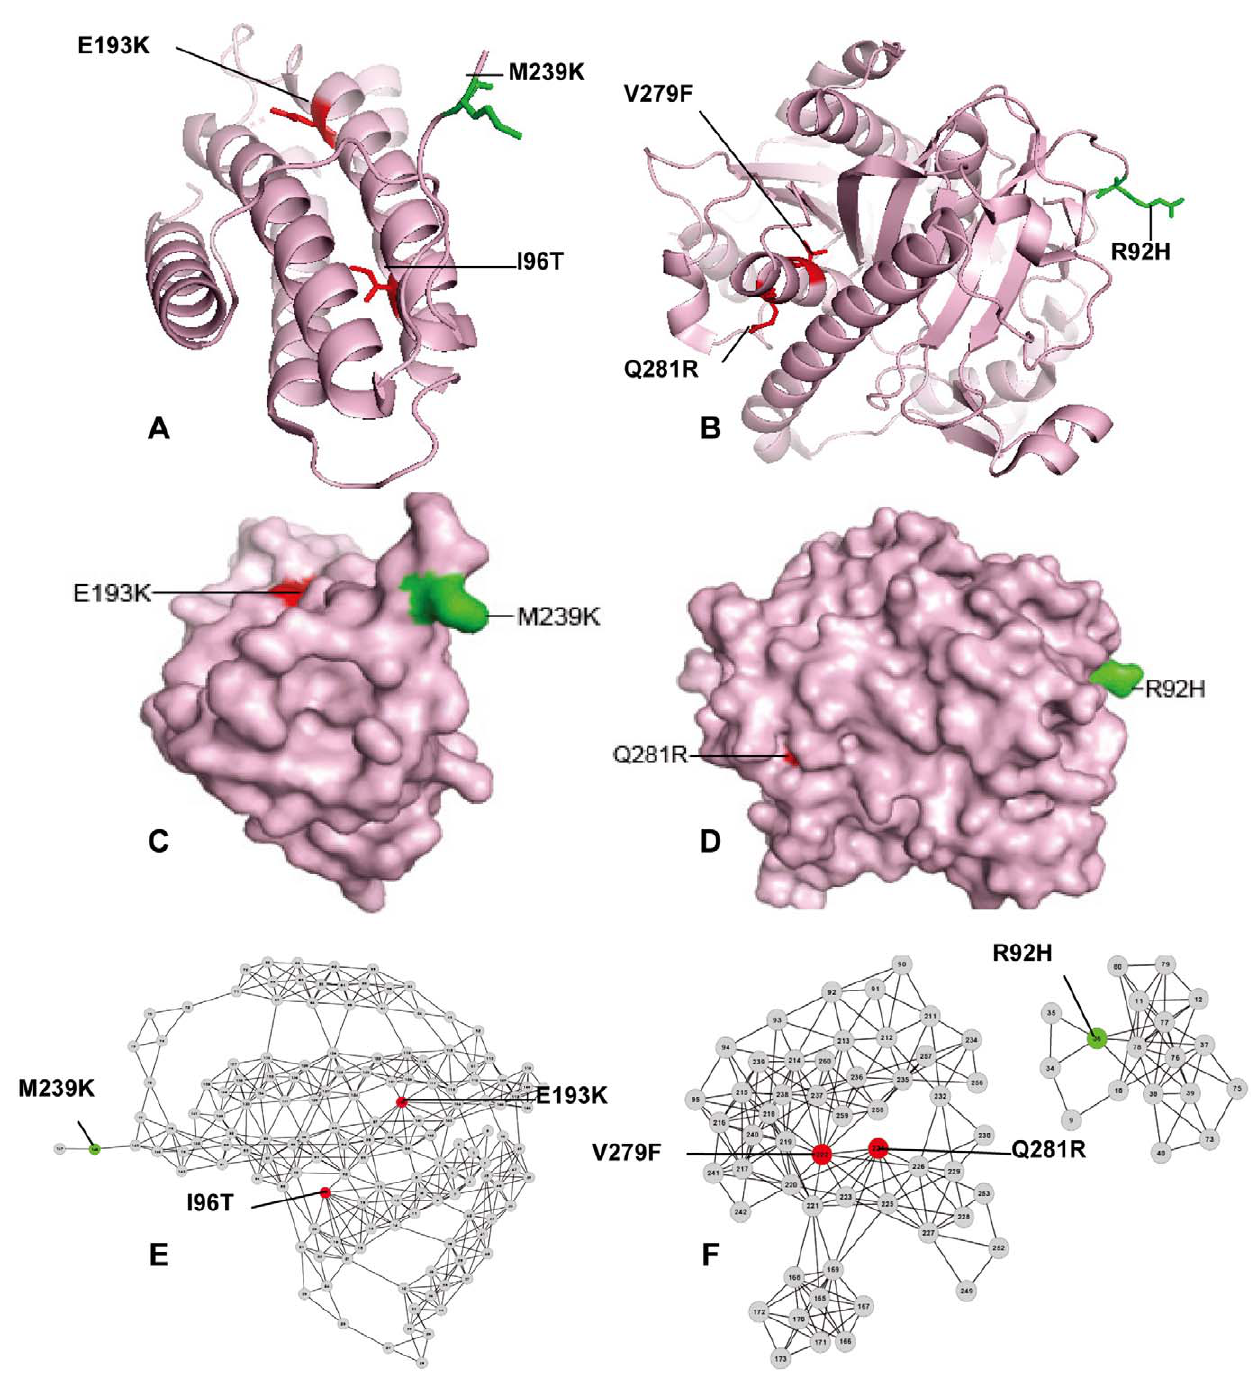
Figure 6. Prediction examples of the functional effect of SAVs in two proteins by FunSAV. (A) and (B) the all-atom; (C) and (D) surface; (E) and (F) network representations of proteins hATR (PDB ID: 2IDX, chain A) and PAF-AH (PDB ID: 3D59, chain A), respectively. Red color denotes disease- associated variants while green color represents neutral variants. 3D structures were rendered using PyMol [71] and network graphs were drawn using Cytoscape [72].